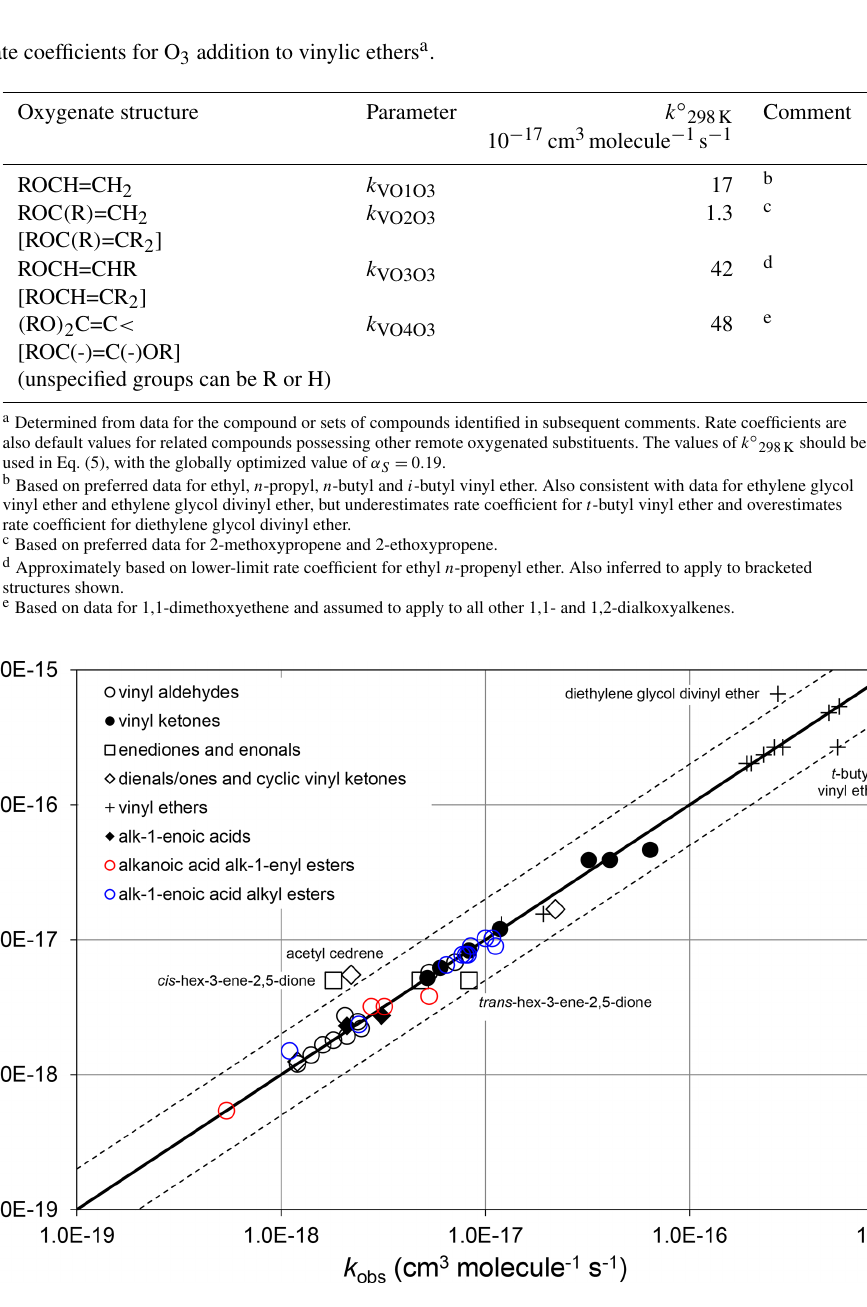
Figure 5. Scatter plot of observed and calculated values of k at 298K for the reactions of O 3 with vinylic oxygenated compounds (see Sect. 4.3). The broken lines show the factor-of-2